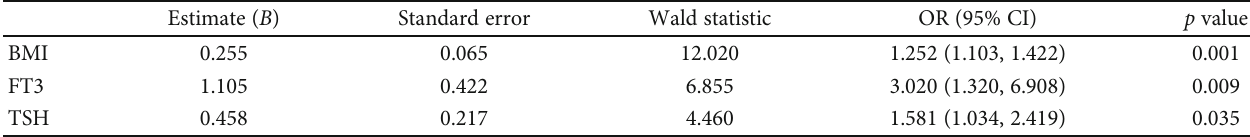
Table 2: Adjusted odds ratios for NAFLD risk.